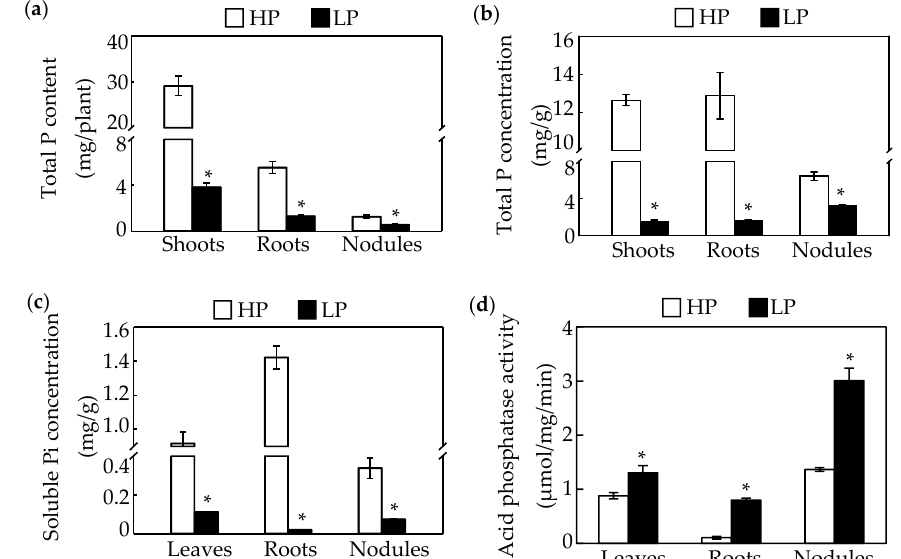
Figure 2. Effects of P deficiency on phosphate (Pi) accumulation and acid phosphatase (APase) activity in soybean. ( a ) Total P content of shoots, roots, and nodules. ( b ) Total Pi concentrations in shoots, roots, and nodules. ( c ) Soluble Pi concentrations in leaves, roots, and nodules. ( d ) Acid phosphatase activity of leaves, roots, and nodules. Data in the figure are mean of four replicates with standard error bars. Asterisks indicate significant difference between HP and LP treatments in the Student’s t -test (*: P <0.05).